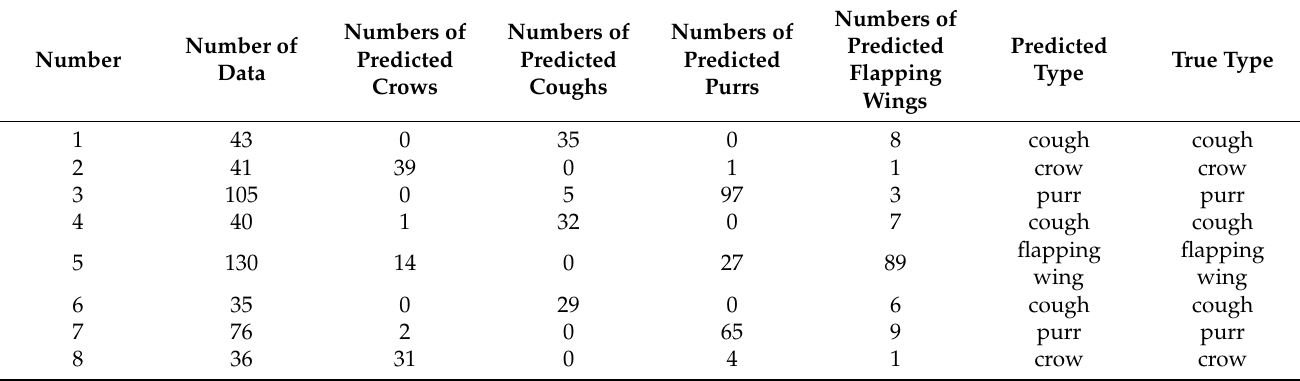
Table 11. Analysis of prediction results of the classification